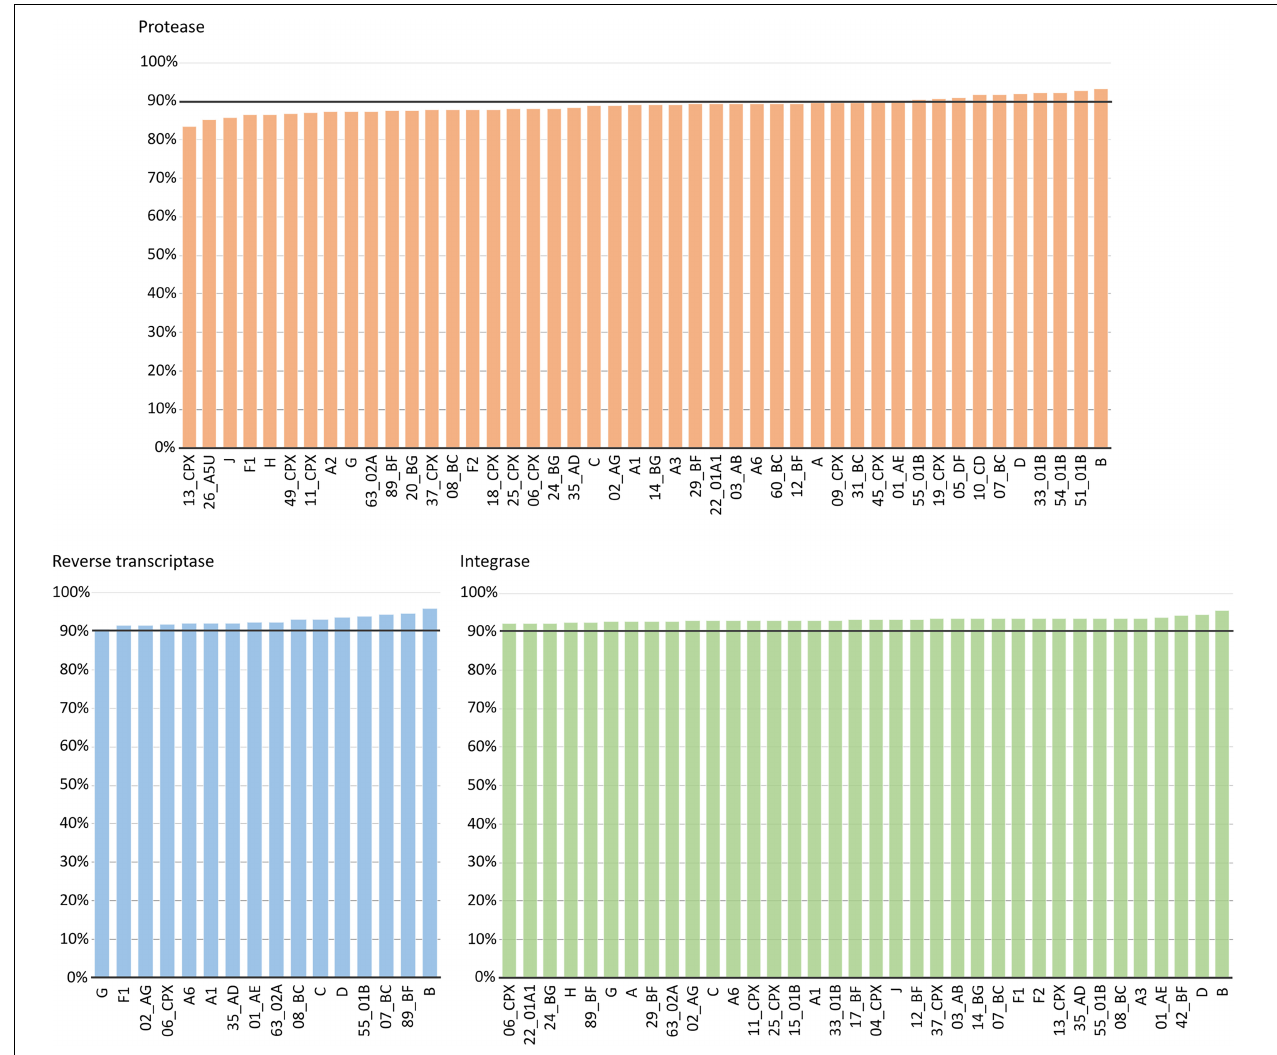
FIGURE 6 | Percentage of aa conservation of PR, RT, and IN across the HIV-1 group M variants with > 5 sequences at LANL. X -axis: HIV-1 group M variants with > 5 available sequences at LANL (46 in PR, 16 in RT, and 36 in IN). Y -axis: conservation rate for each variant included in this analysis. The horizontal line represents 90%